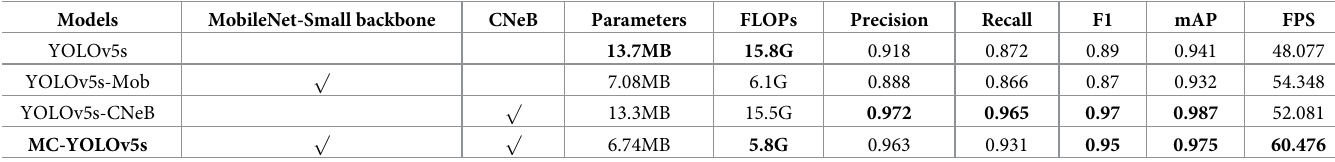
Table 6. Comparison of performance indicators for ablation experiments. Models